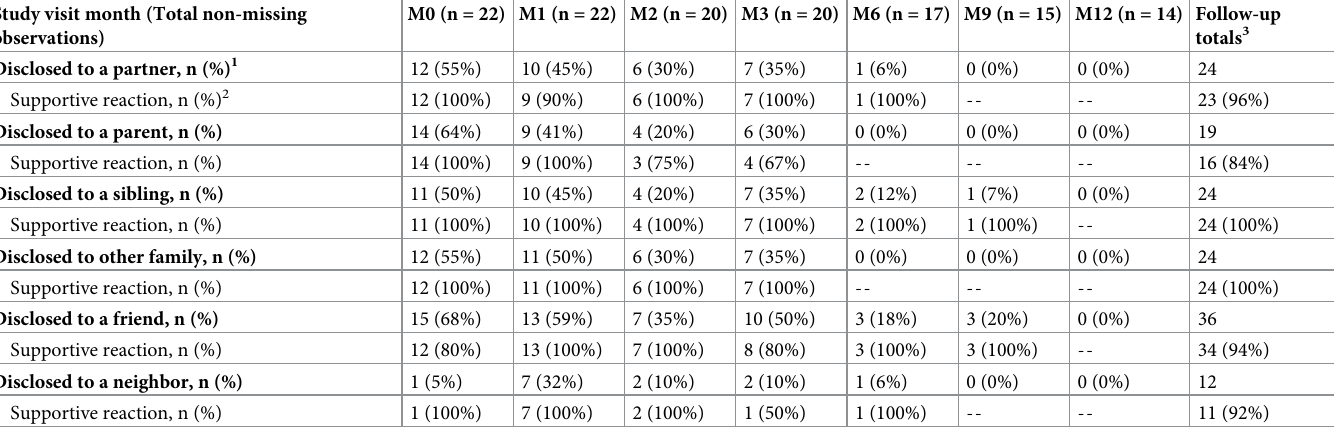
Table 2. Disclosure and social support report since last study